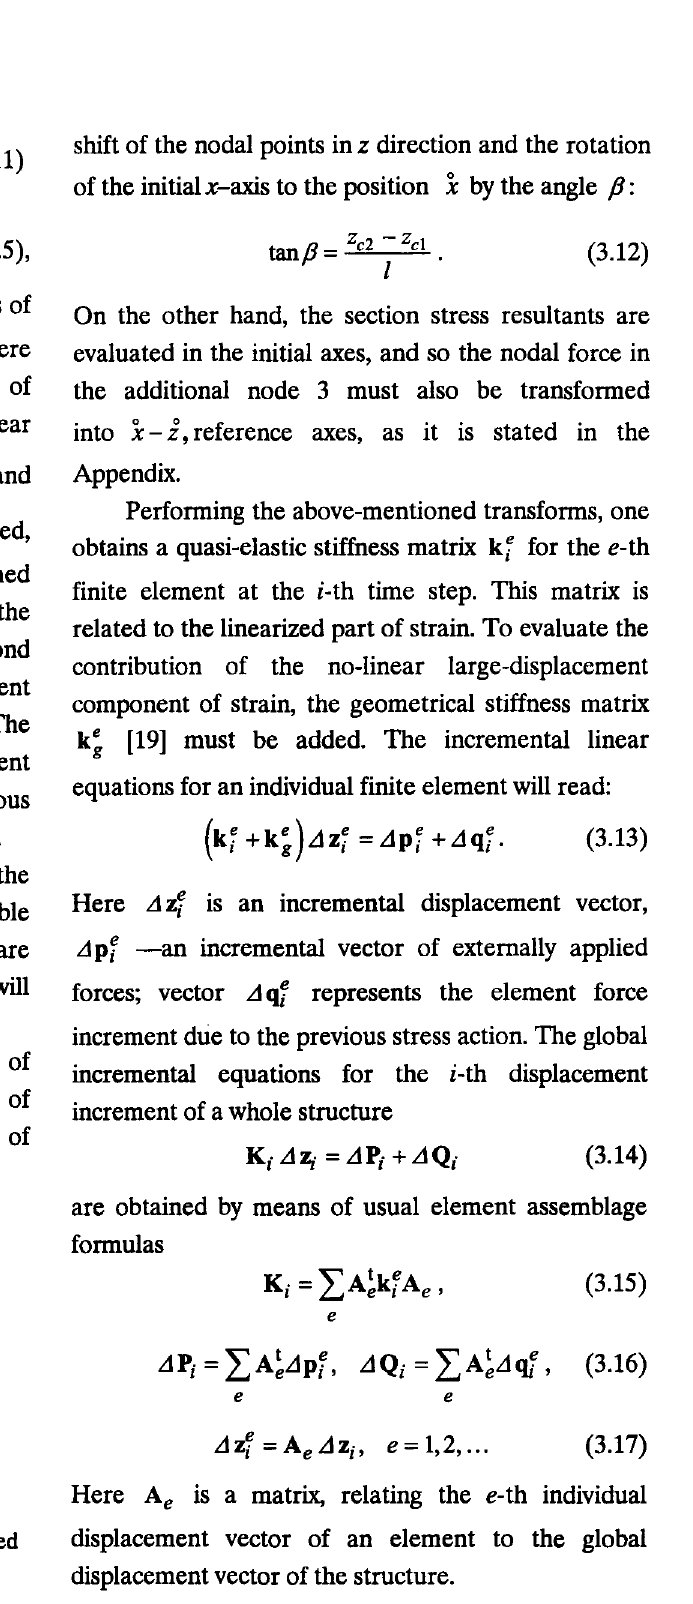
Fig. 3.1. Initial reference axesx- z and incremental shifted z reference axes i - of a finite